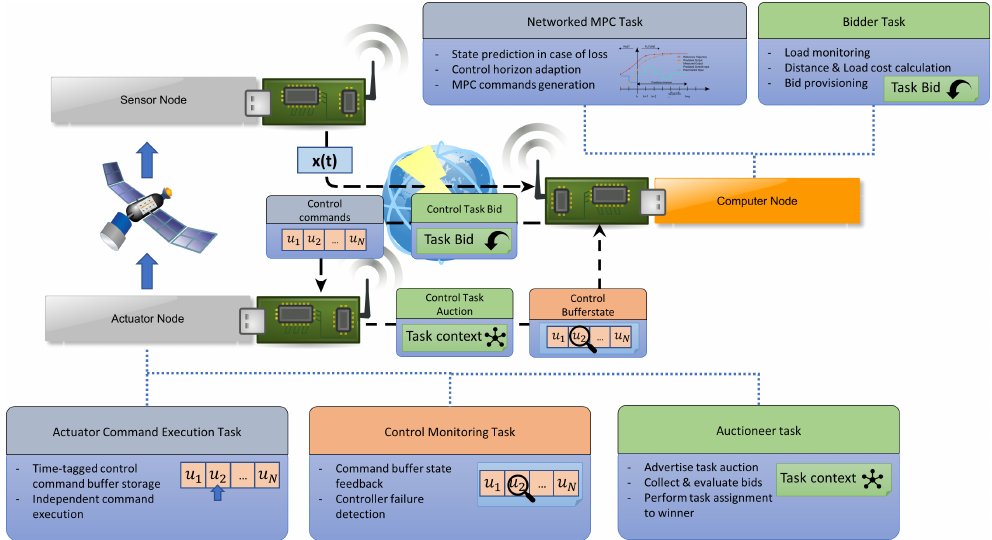
Figure 12. Diagram of the networked control loop architecture extended to deal with controller